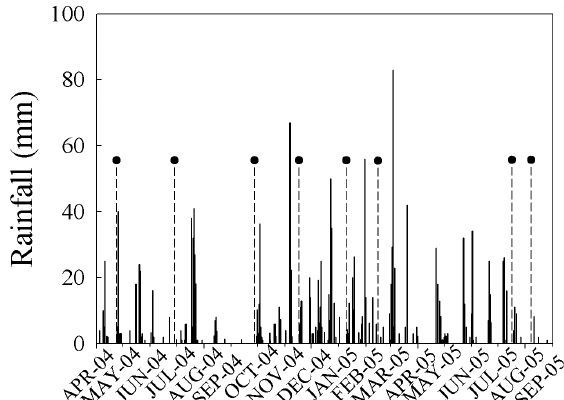
Figure 1 - Daily rainfall (mm) during the period of study. The dashed lines indicated by black circles represent the months in which Ψ and chlorophyll a fl uorescence were L